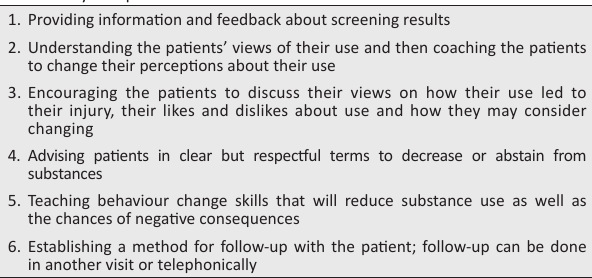
BOX 10: Key components of brief interventions. 50